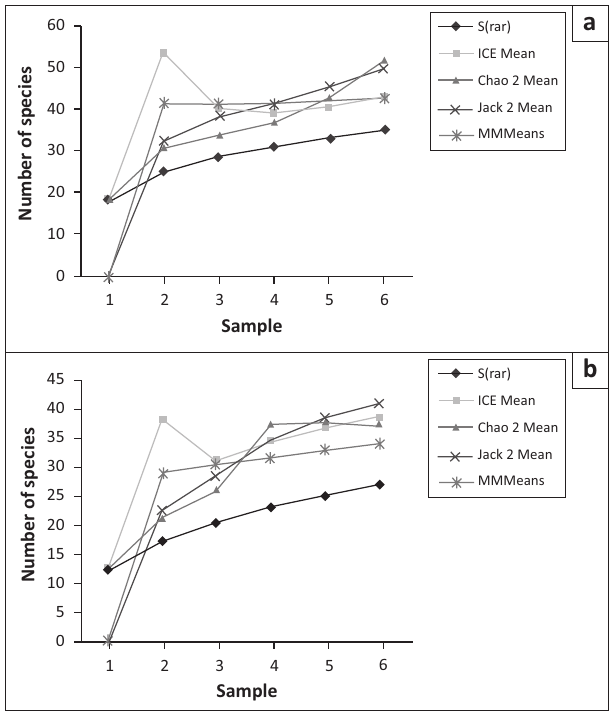
FIGURE 1-A1: Sample-based rarefaction curves indicating the number of species (Srar), ICE mean (incidence-based coverage estimator), Chao 2 mean